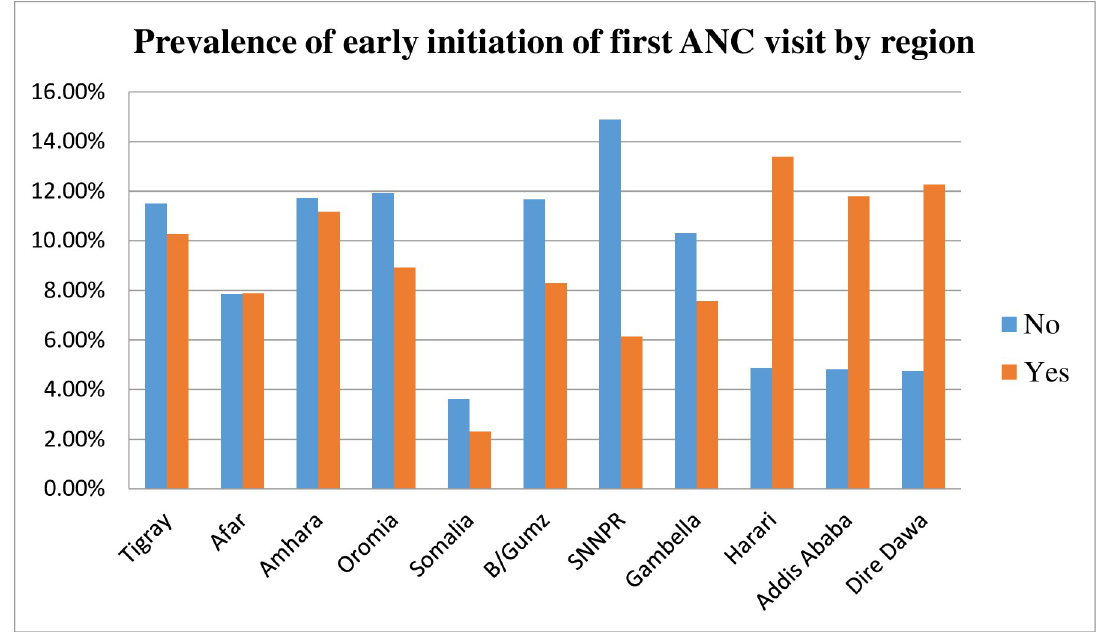
Fig 2. The prevalence of early initiation of first ANC visits by regions in Ethiopia, 2019.